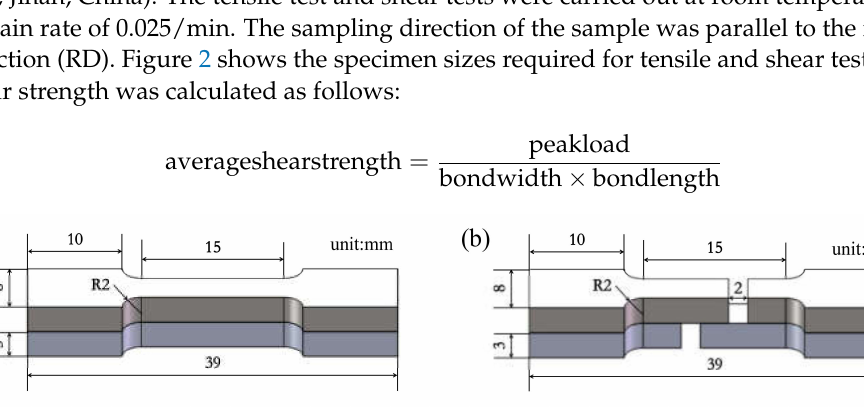
Figure 2. Sample dimensions: ( b ) tensile sample, ( a ) shear